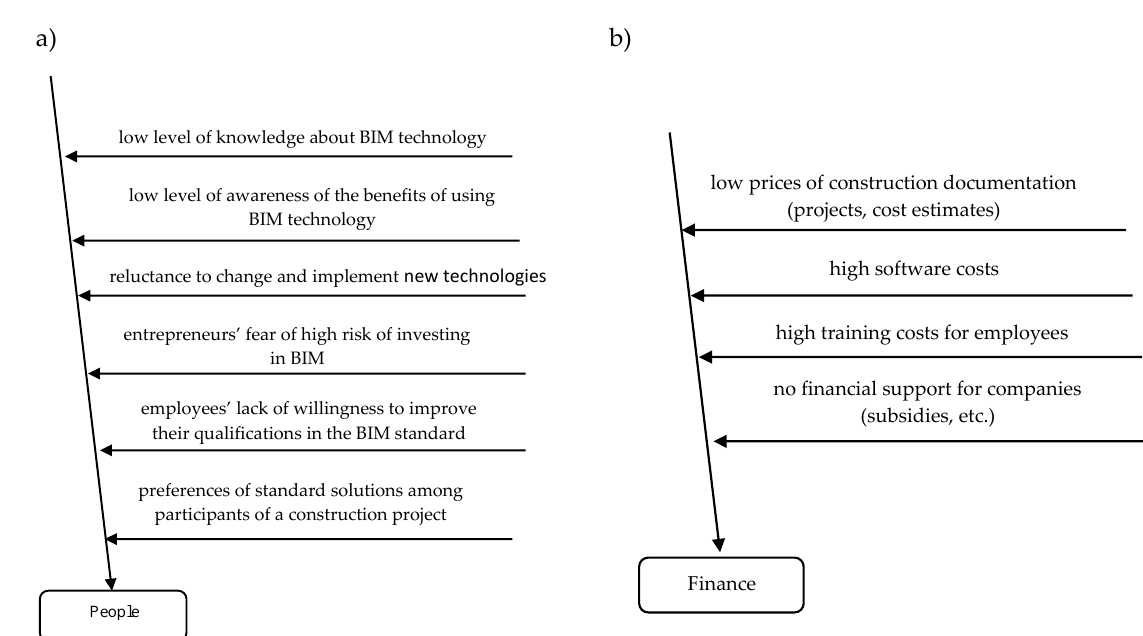
Figure 5. Reasons for the poor implementation of BIM in Poland ( a ) in the People category; ( b ) in the Finance category.